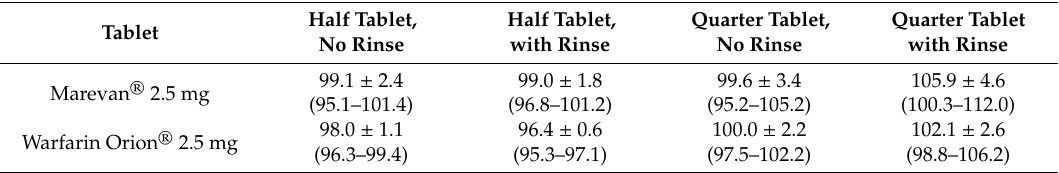
Table 5. Dispersing a fragment: Per cent recovered for fragments of warfarin tablets dispersed in